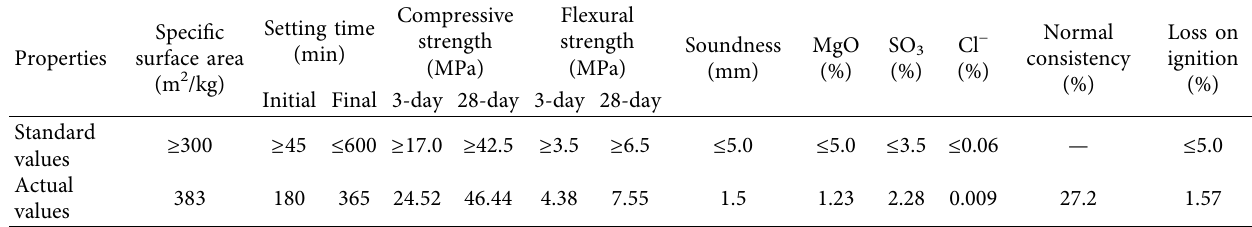
Table 1: Inspection report of cement.